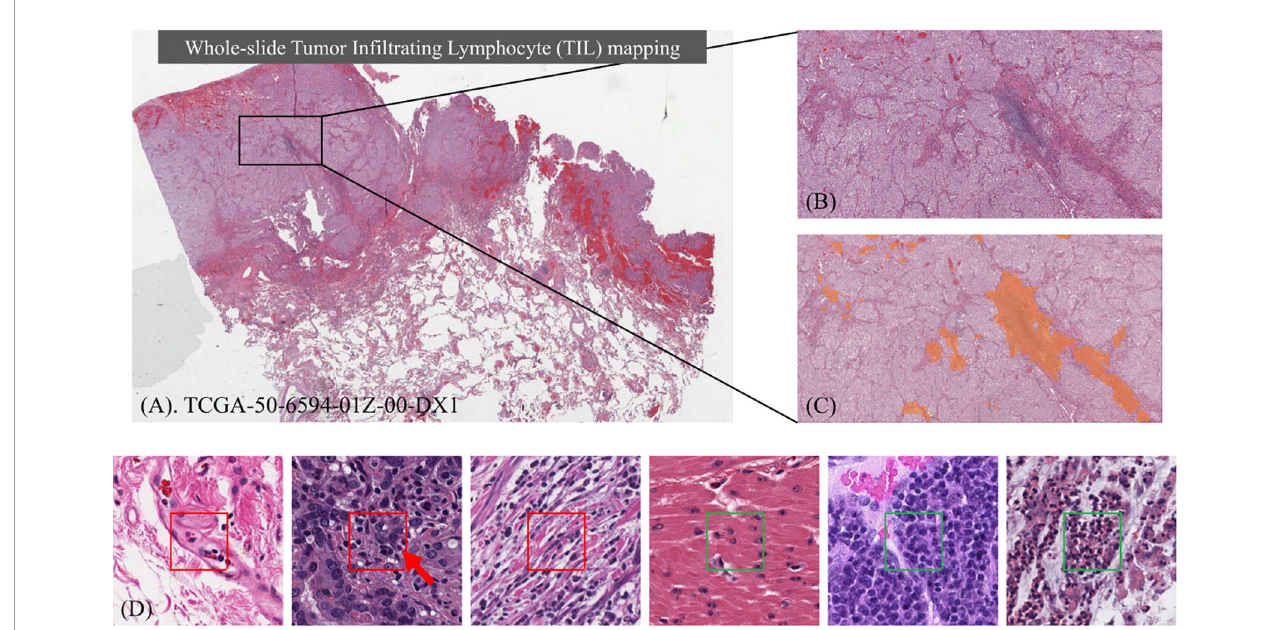
FIGURE 1 | Identifying Tumor In fi ltrating Lymphocyte (TIL) regions in gigapixel pathology WSIs. (A) H&E stained WSI of lung adenocarcinoma. (B) Example of a region of tissue. (C) Example of a TIL map overlaid on the region of tissue. (D) Examples of TIL positive (framed in red) and negative (framed in green) patches. A lymphocyte is typically dark, round to ovoid, and relatively small compared to tumor and normal nuclei. Sample patches show the heterogeneity in TIL regions and how it can be challenging to differentiate TIL positive and TIL negative